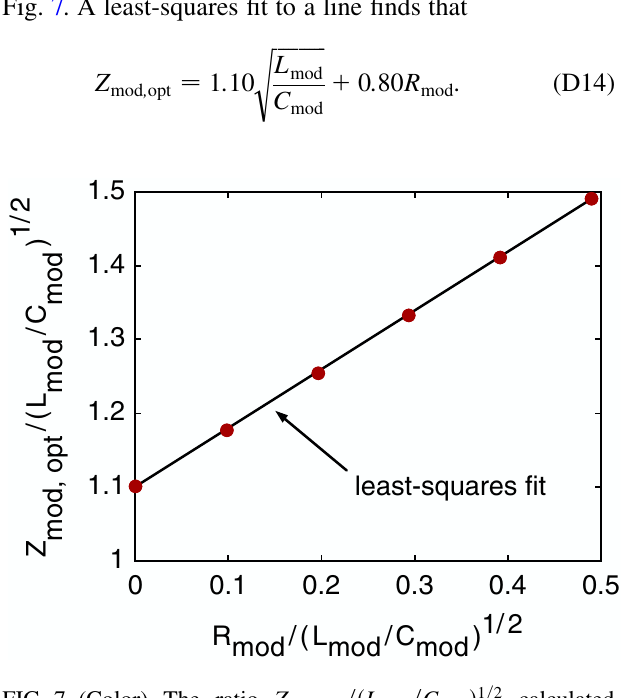
FIG. 7. (Color) The ratio Z numerically at six different values of R The numerical results suggest a linear relationship. The solid black line is a least-squares fit to a line; the slope and intercept are 0.80 and 1.10,